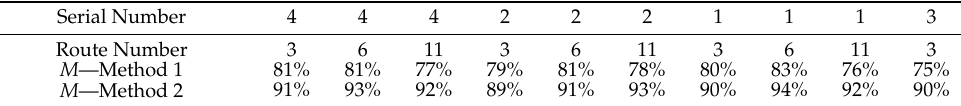
Table A1. Obtained values of the M parameter.